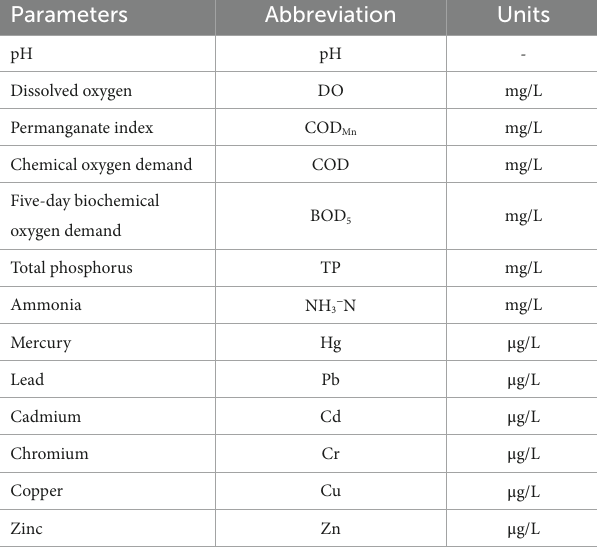
TABLE 2 The 13 water quality parameters monitored in this